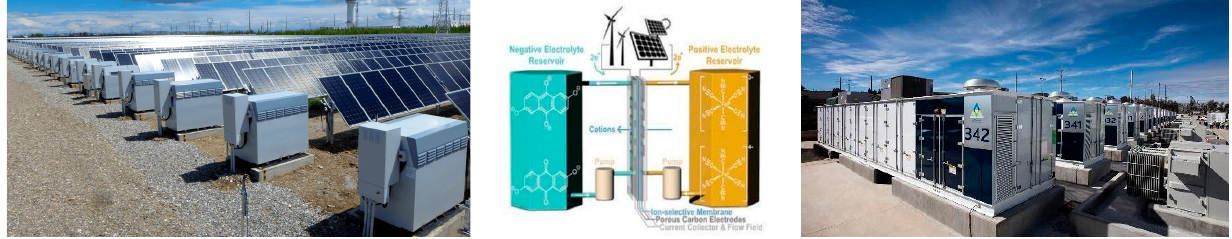
Figure 19. The largest battery storage facility in Texas [40].